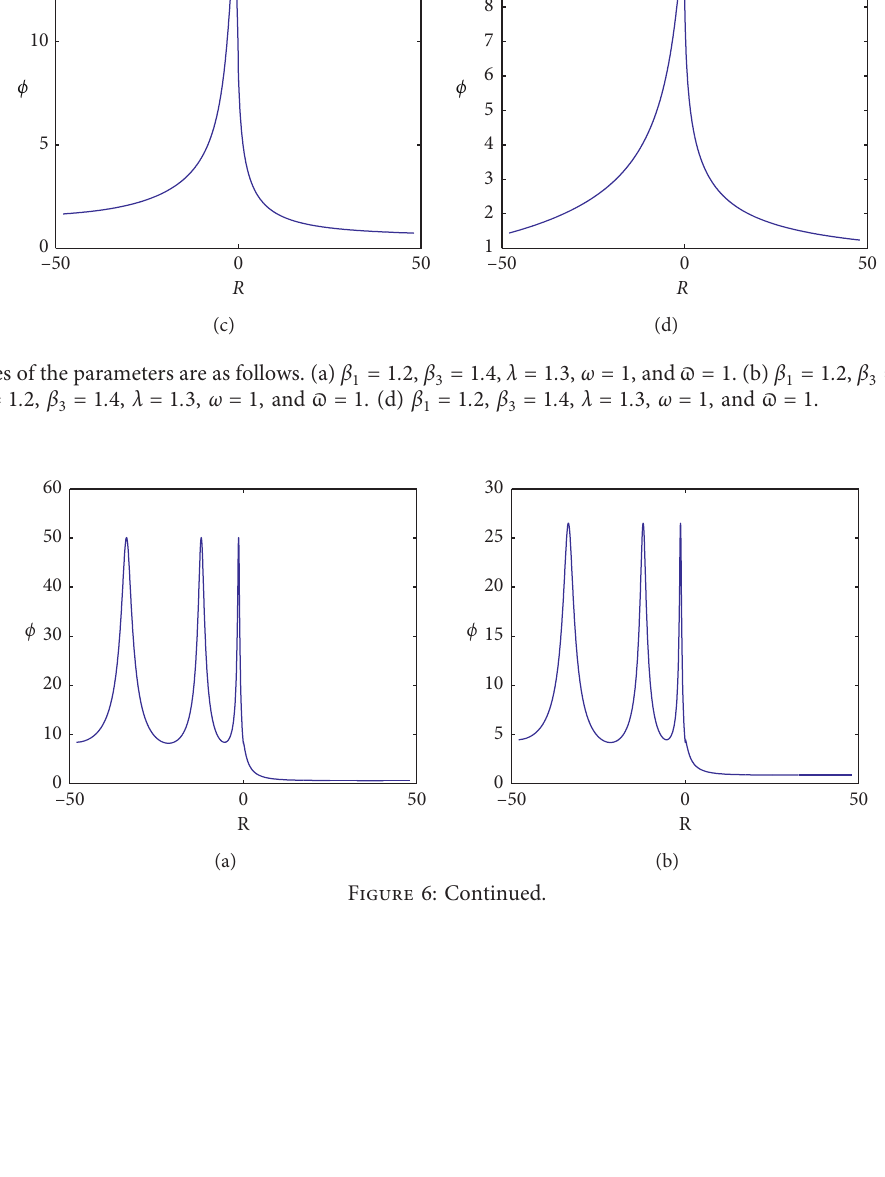
� 1 . 2, β � 1 . 4, λ � 1 . 3, ω � 1, 1 3